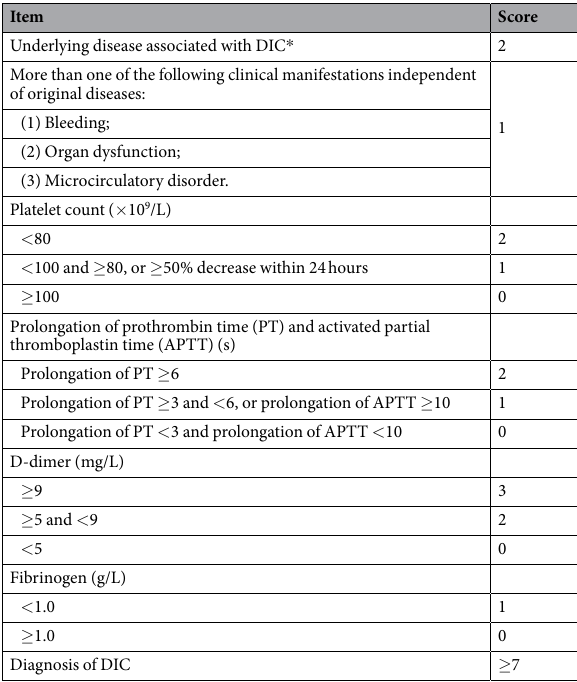
Table 1. Chinese Disseminated Intravascular Coagulation (DIC) Scoring System (CDSS). * If underlying disease is hematological malignancy: (1) No point for bleeding; (2) 1 point for platelet count of < 50 × 109/L or ≥ 50% decrease within 24 hours; 3) Diagnosis of DIC is ≥